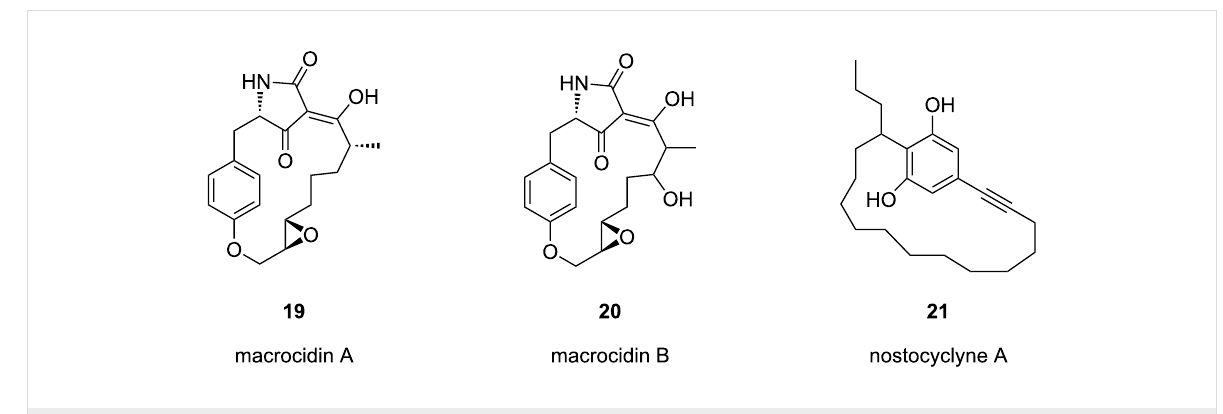
Figure 4: Natural products containing the cyclophane skeleton.